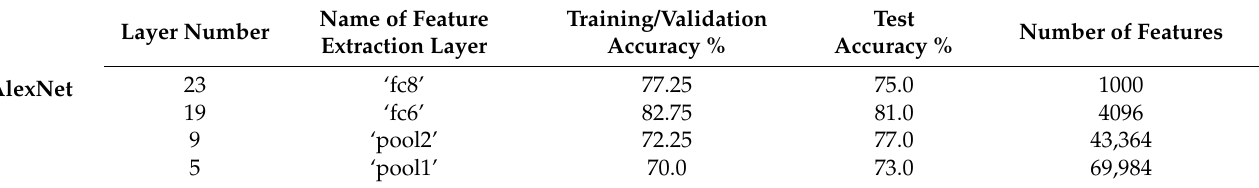
Table 6. Classification performance of SVM using the autonomous features from AlexNet.